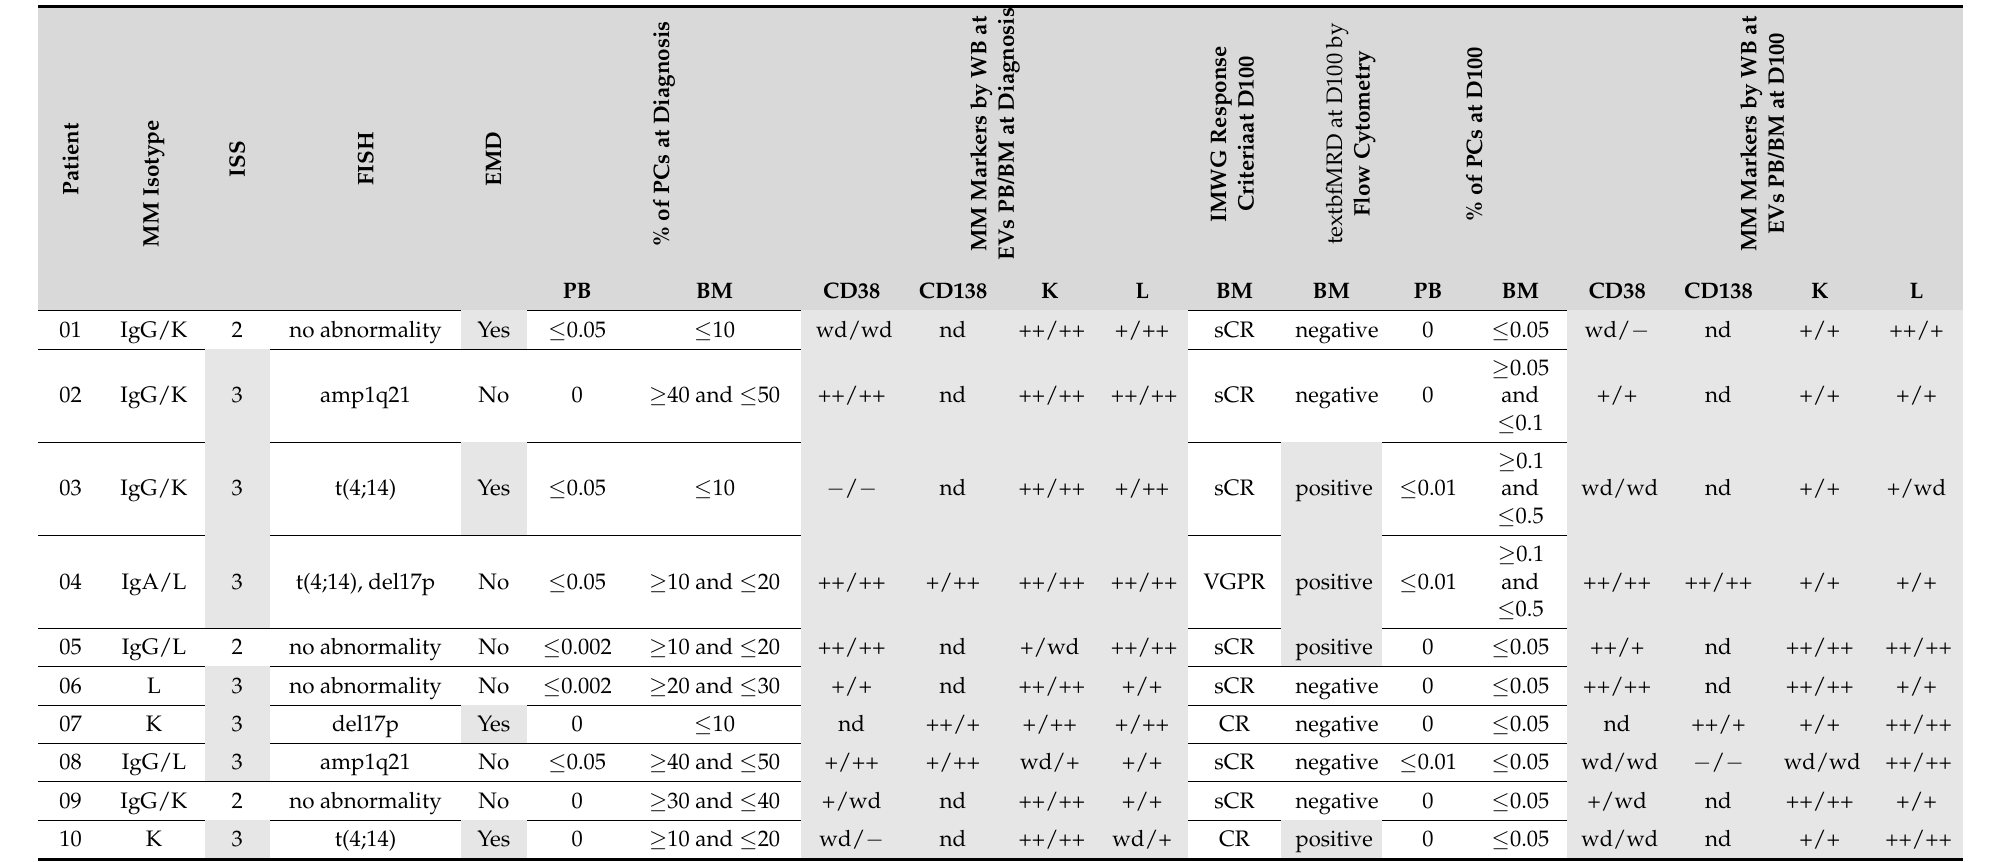
Table 1. Comparison of Multiple Myeloma (MM) patients’ characteristics at diagnosis and at day 100 of evaluation regarding response criteria, measurable residual disease (MRD) by flow cytometry, and Extracellular Vesicle (EV) markers both in peripheral blood (PB) and bone marrow